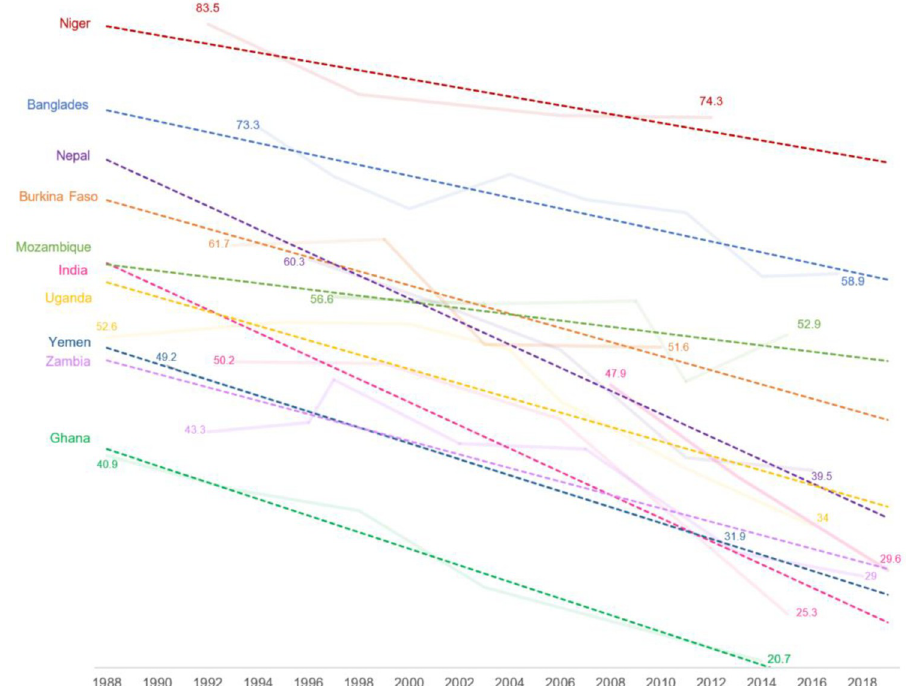
Fig 1. Trendlines in proportion of women ages 20–24 married by exact age 18, DHS 1988–2019. Bold, dotted lines show trendlines for each country. Light-shaded lines show available data, with earliest and latest datapoints represented for each